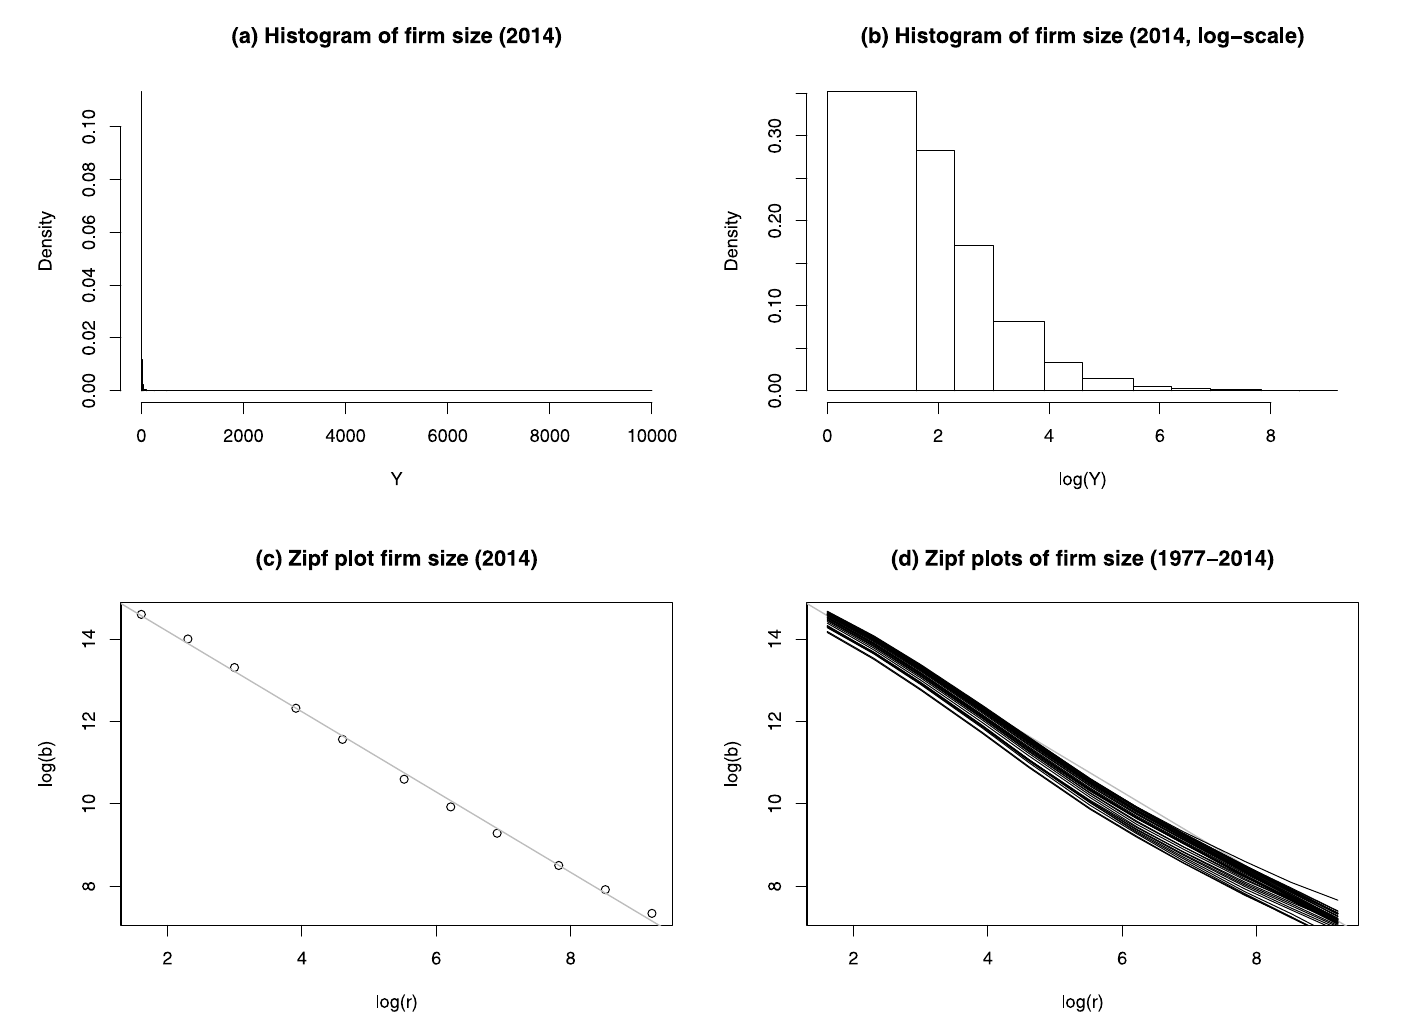
Fig 3. US private-sector firm size data. (a) Histogram of 2014 US firm size data. (b) Histogram of 2014 US firm size data after a logarithm transformation. To avoid infinite boundaries, we set B 0 ¼ 1 . (c) Zipf plot of the 2014 US firm size data. The straight-line is the fitted least squares line to the Zipf plot. (d) Zipf plots of firm size 0 data for years from 1977 to 2014.